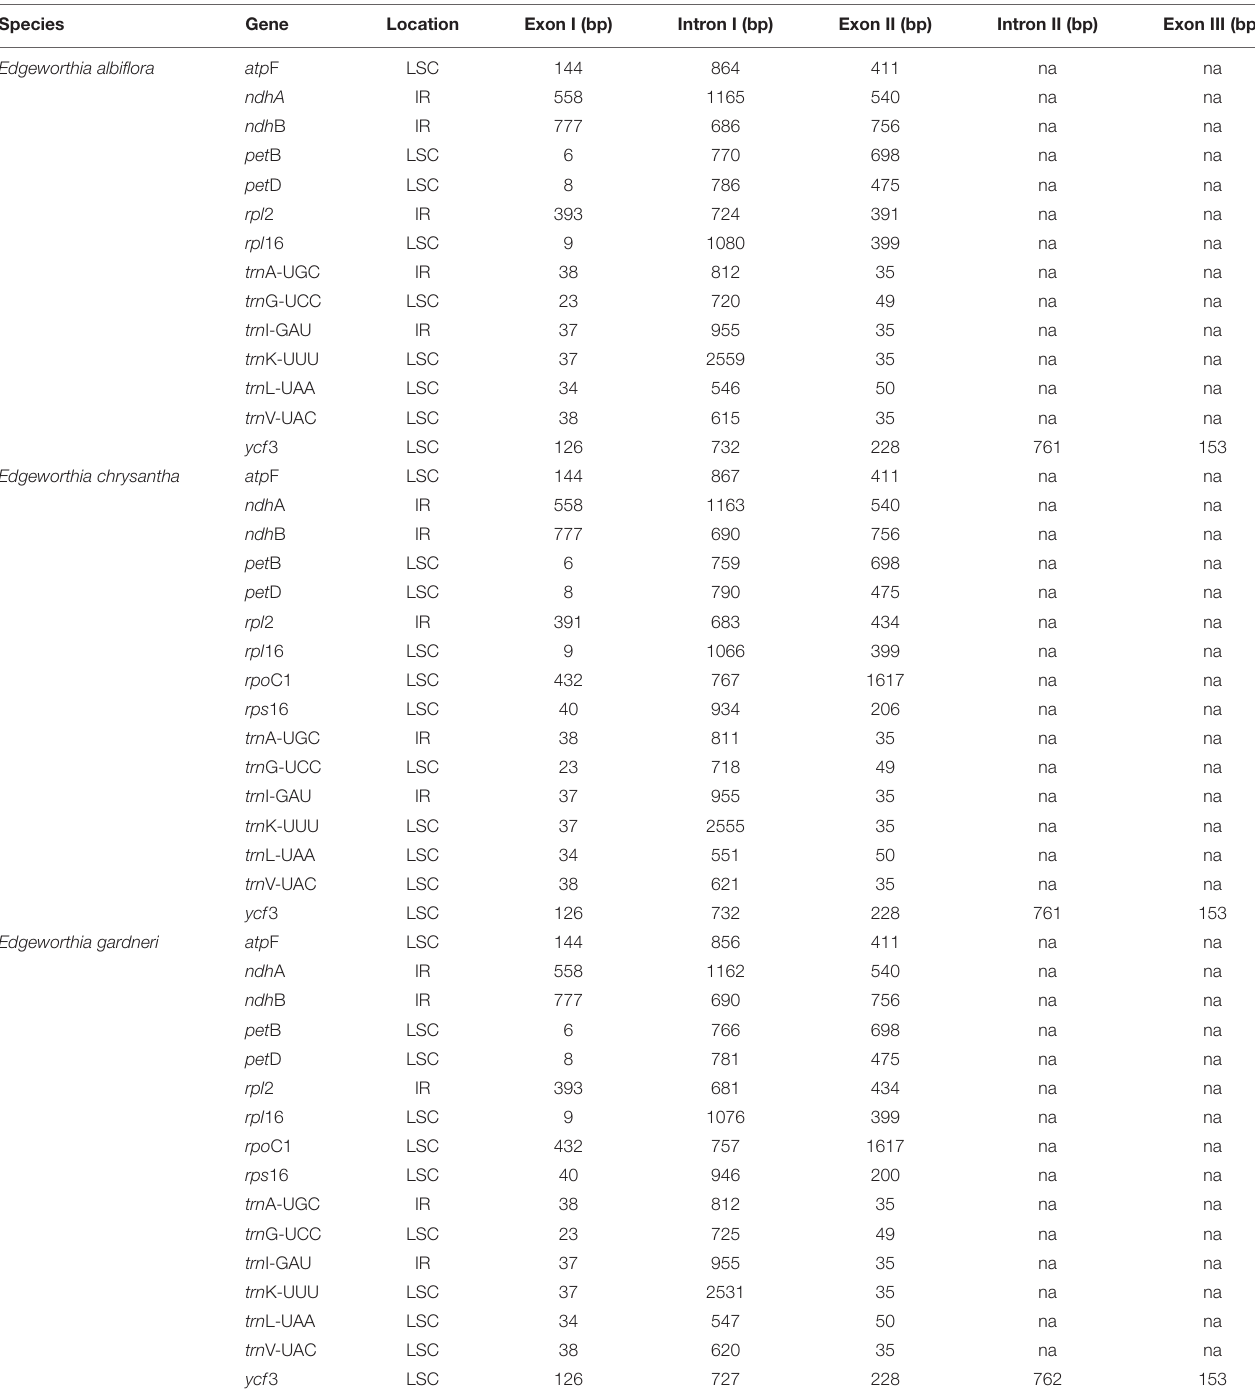
TABLE 3 | Locations and sizes of the intron-containing genes recorded in the chloroplast genome of the three Edgeworthia species. Species Gene Location Edgeworthia